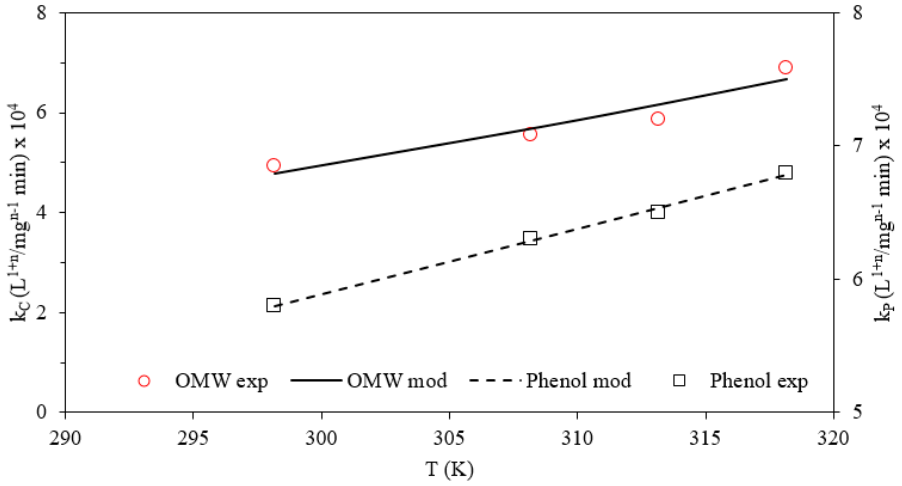
Figure 6. Kinetic constant values at different temperatures (point) and fitted Arrhenius model (line) (T = 25, 35, 40, and 45 °C; initial OMW COD = 9.4 g L − 1 ; synthetic solution initial concentration = 25 mg L − 1 ; impeller rotational velocity = 200 rpm).